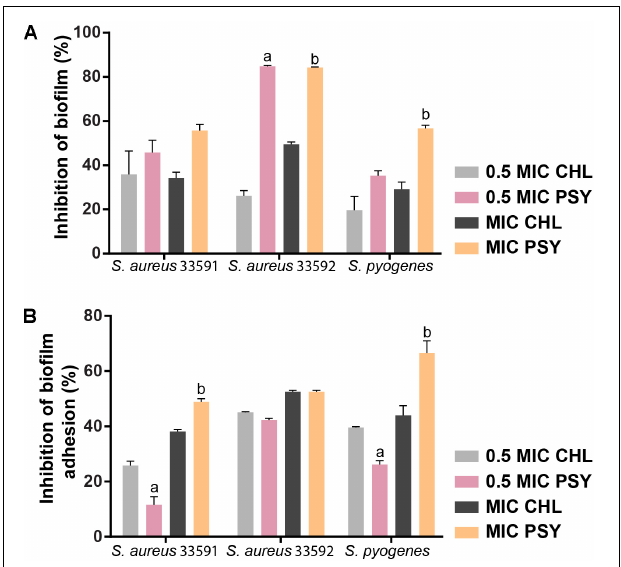
FIGURE 5 | The effect of psychorubrin (PSY) on established biofilms (A) of S. aureus 33591, S. aureus 33592, and S. pyogenes 10096 and on their adherence ability (B) . Choramphenicol (CHL) was used as positive control. Each data point represents mean ± SD from at least two independent experiments performed in triplicate. a Statistically different from chloramphenicol (MIC value). b Statistically different from chloramphenicol (0.5 MIC value) (ANOVA followed by Bonferroni, P < 0.05).